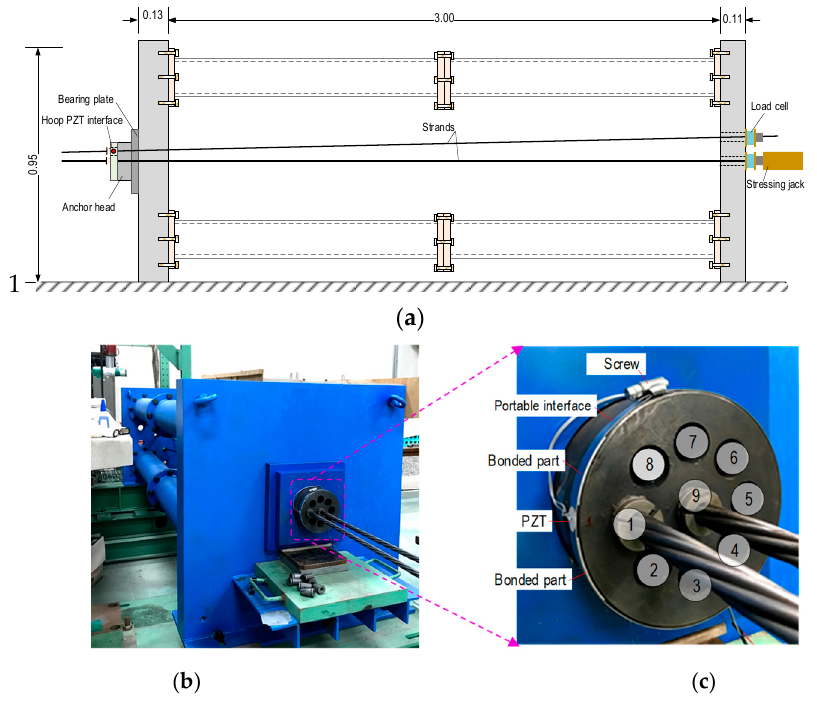
Figure 19. Experimental set-up of the multi-strand anchorage system. ( a ) Overview of the test setup (unit: m), ( b ) prestressed multi-strand anchorage system, and ( c ) hoop PZT interface mounted on the anchor head.